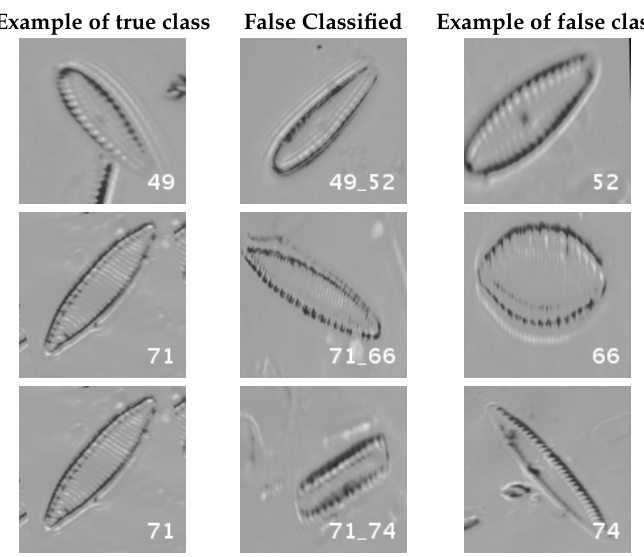
Figure 17. Normalized dataset main confusions (part 2). Each row shows an example of the true species, a missclassifed sample between two species and a sample of the second one are shown.